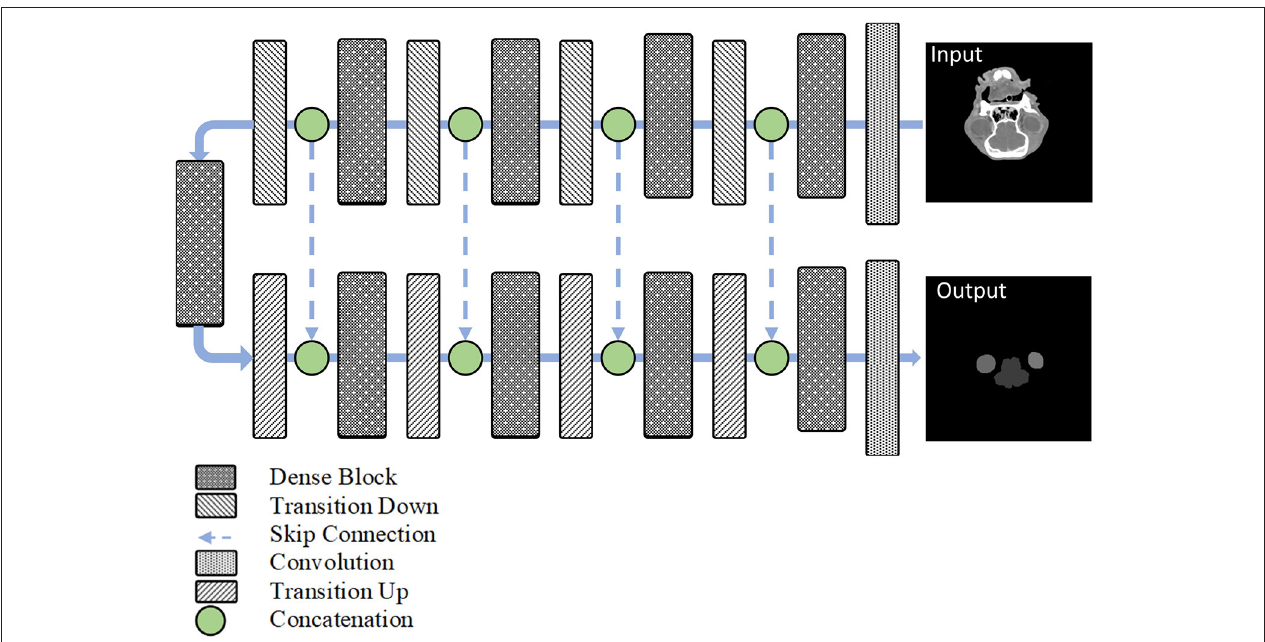
FIGURE 2 | The architecture of the proposed fully convolutional DenseNet.